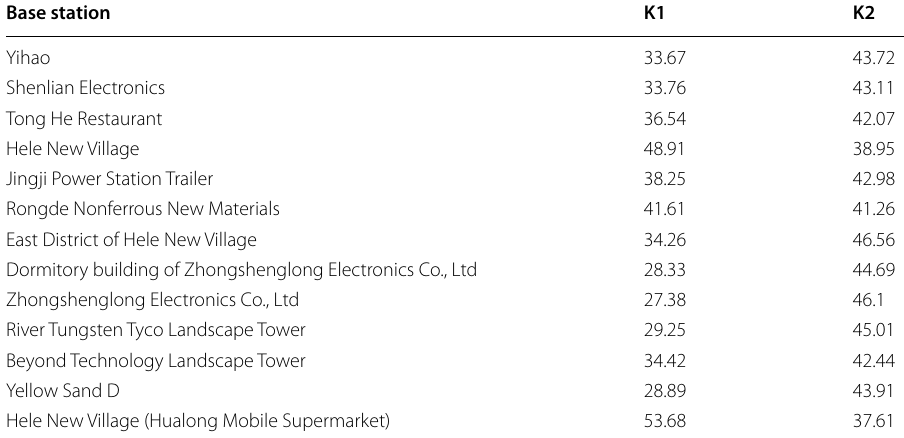
Table 6 Values of the test base stations Base station